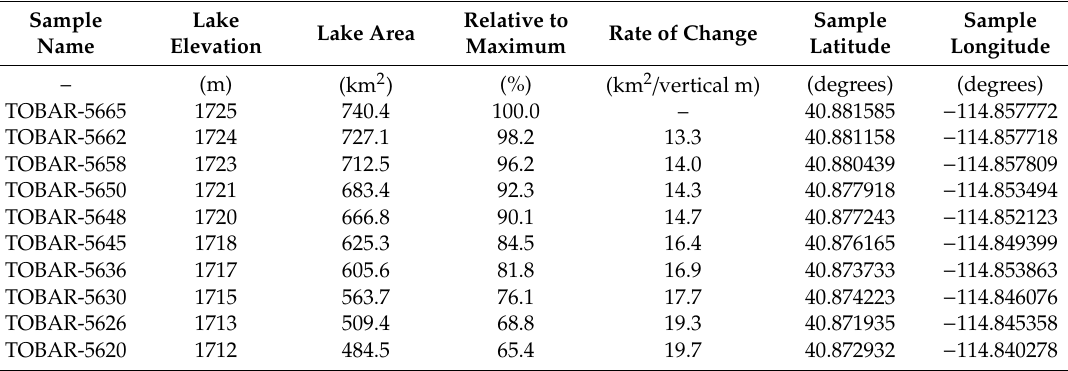
Table 1. Samples from the Tobar